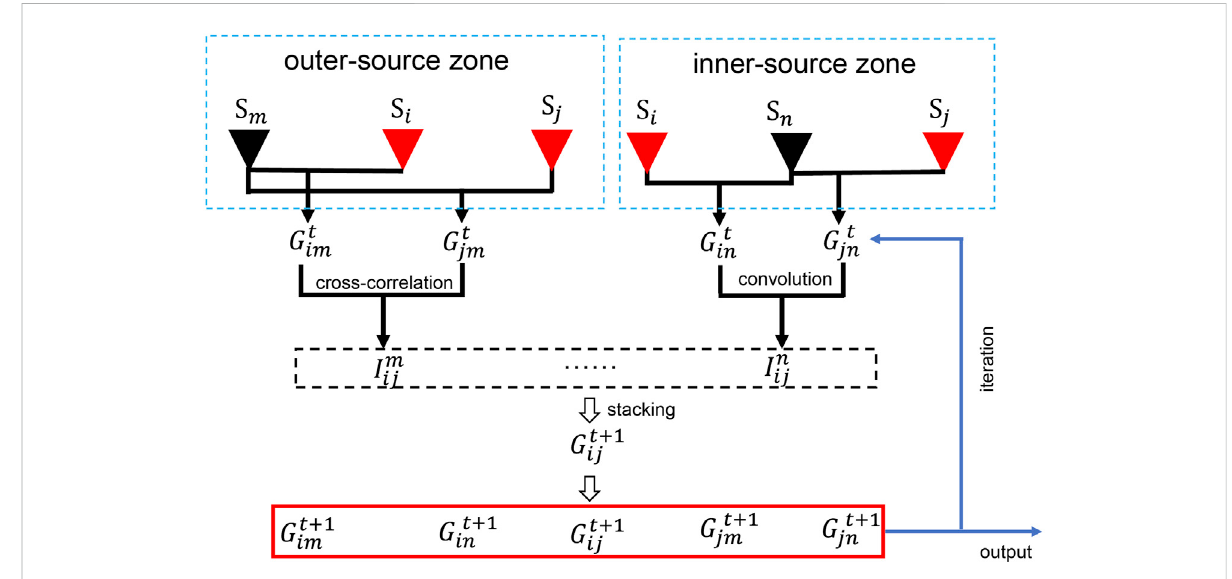
FIGURE 4 SketchoftheTSImethod.Theredtriangles( S i and S j )indicatethechannelpairwhoseNCFistobeenhanced,andtheblacktrianglesarethethird